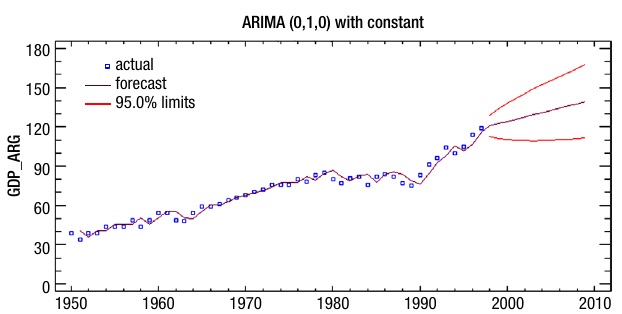
Fig. 18. Time sequence plot for time series of annual Argentinian